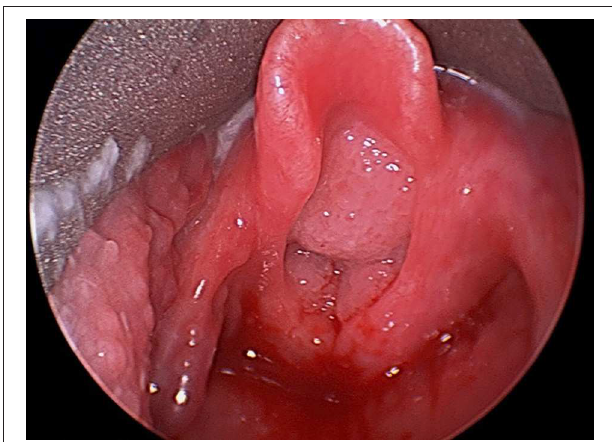
FIGURE 1 | Direct laryngoscopic image of large bulky airway papillomatosis obstructing the laryngeal